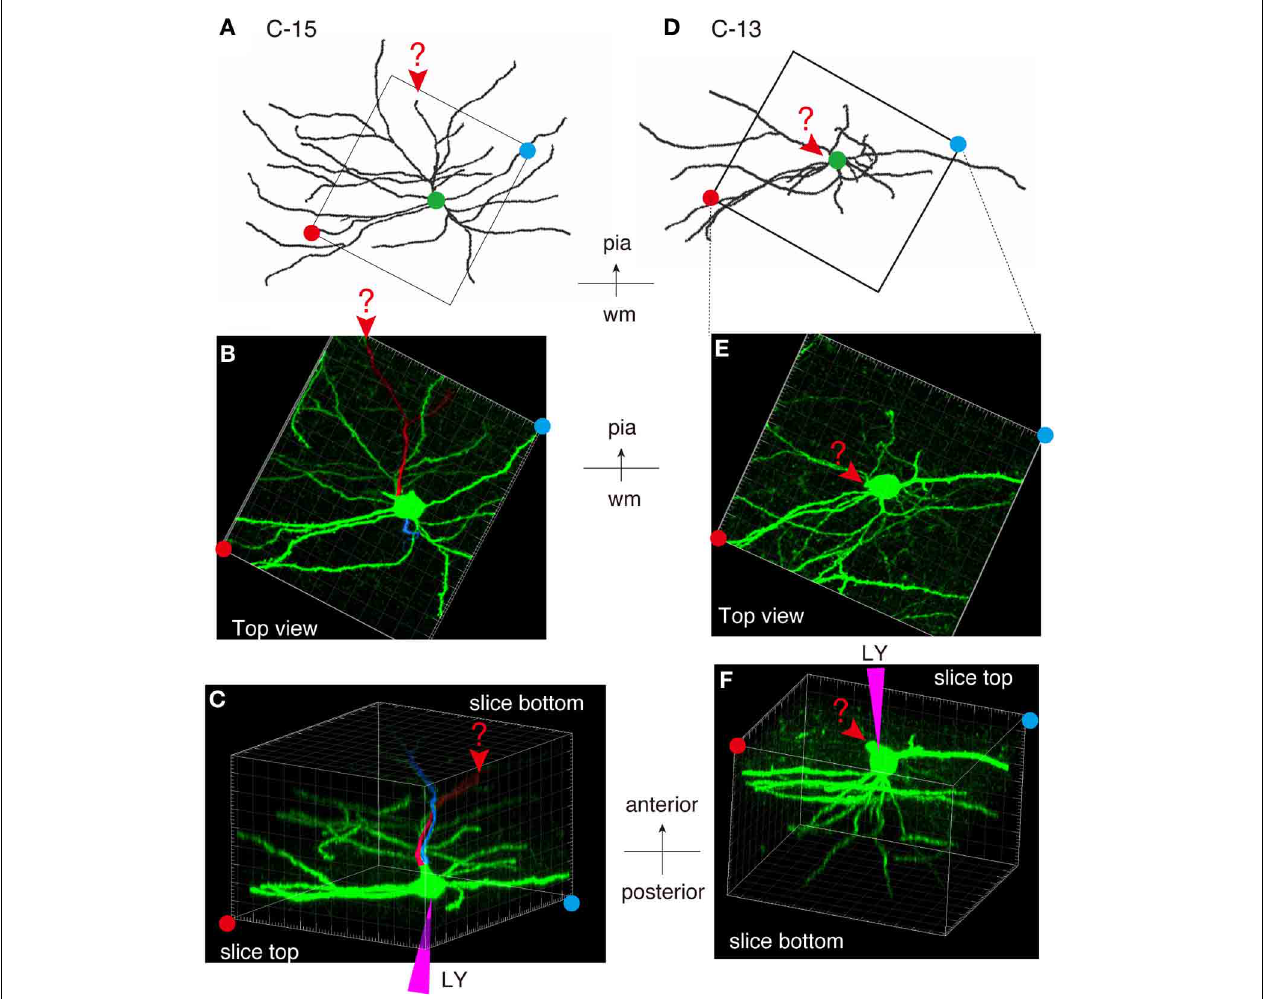
FIGURE 9 | Examples of atypically oriented pyramidal cells in the claustrum. (A) Dendritic reconstruction of a claustral cell (C-15) shown in Figure 8D . The region indicated by the square was cut off for 3D reconstruction of the confocal stack images in (B,C) . Note the orientation of the neuron: the top is to the pia matter of the insular cortex. (B) A maximal projection stack of confocal images of the region shown by a rectangle in (A) was viewed from the top surface of the slice. In this view, there does not appear to exist apical dendrites. (C) The 3D reconstruction of the confocal images for C-15 was rotated so that the slice is viewed obliquely from the bottom side. Note the positions of the red and blue circles, which indicated